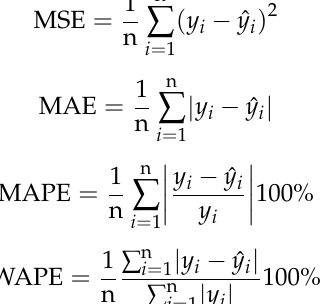
Figure 2. Predictive model test for a specific product and branch: ( a ) Gradient Boosting; ( b ) XGBoost. Table 1. Setting of hyperparameters for the developed XGBoost model.